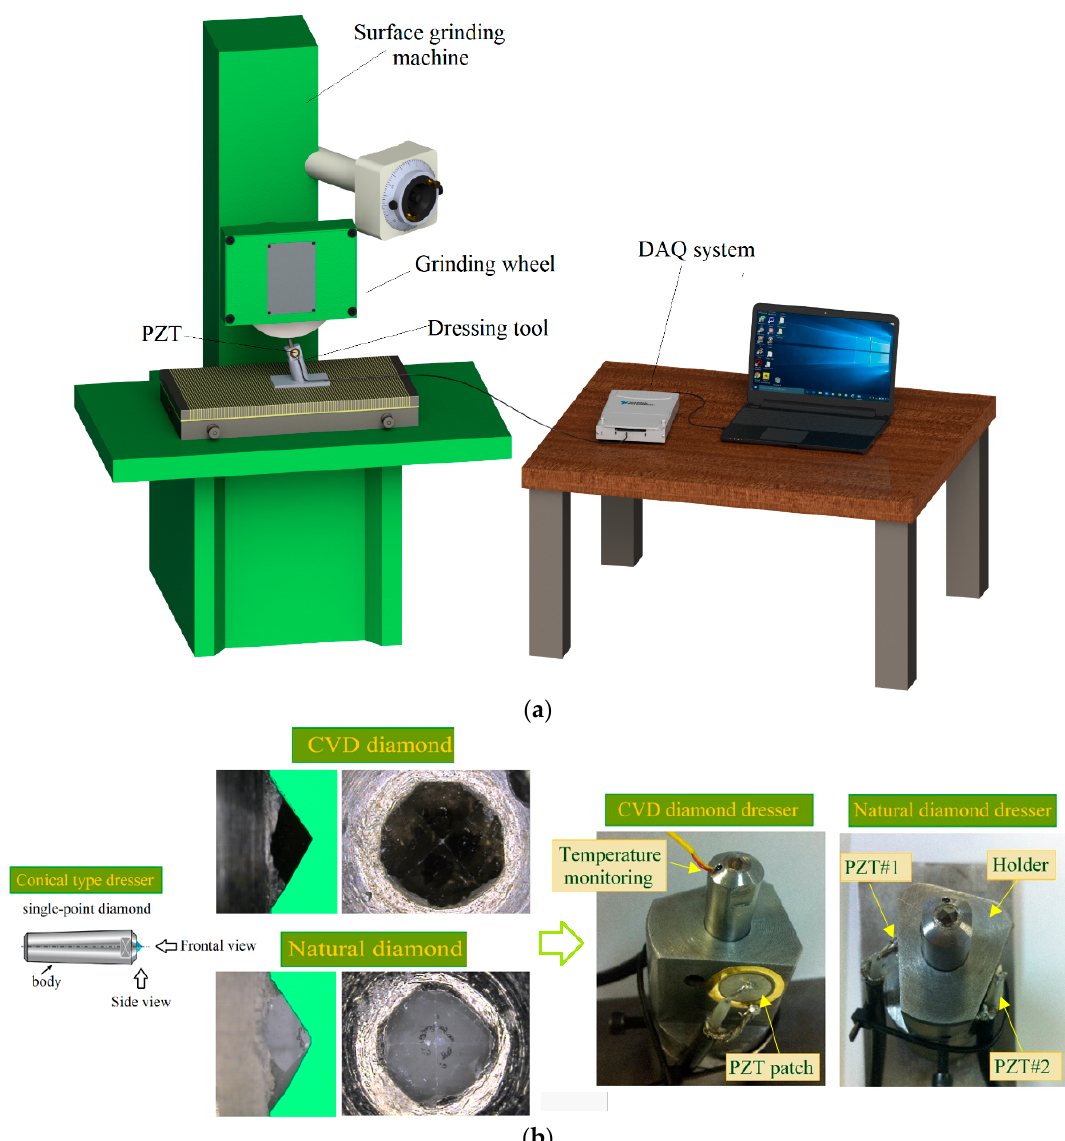
Figure 1. Proposed sensing setup for dressing tool condition monitoring (Part 2): ( a ) schematic representation of the test bench; and ( b ) the two types of diamond dressing tools and the two lead zirconate titanate (PZT) transducers for experimental testing; configuration of the dresser body; top and side views of the diamonds. (DAQ: multifunctional data acquisition; CVD: chemical vapor deposition)